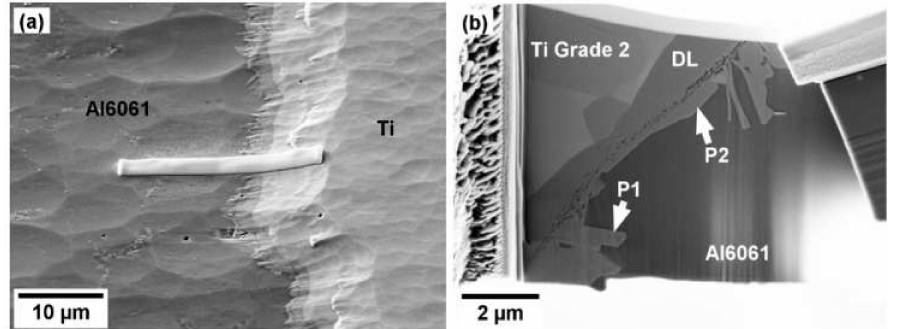
Figure 6. ( a ) Lamella position on the interface. ( b ) The finished lamella showing the interface cross- section. The diffusion layer (DL) and the precipitates (P1 and P2) investigated further by the TEM (see below) are